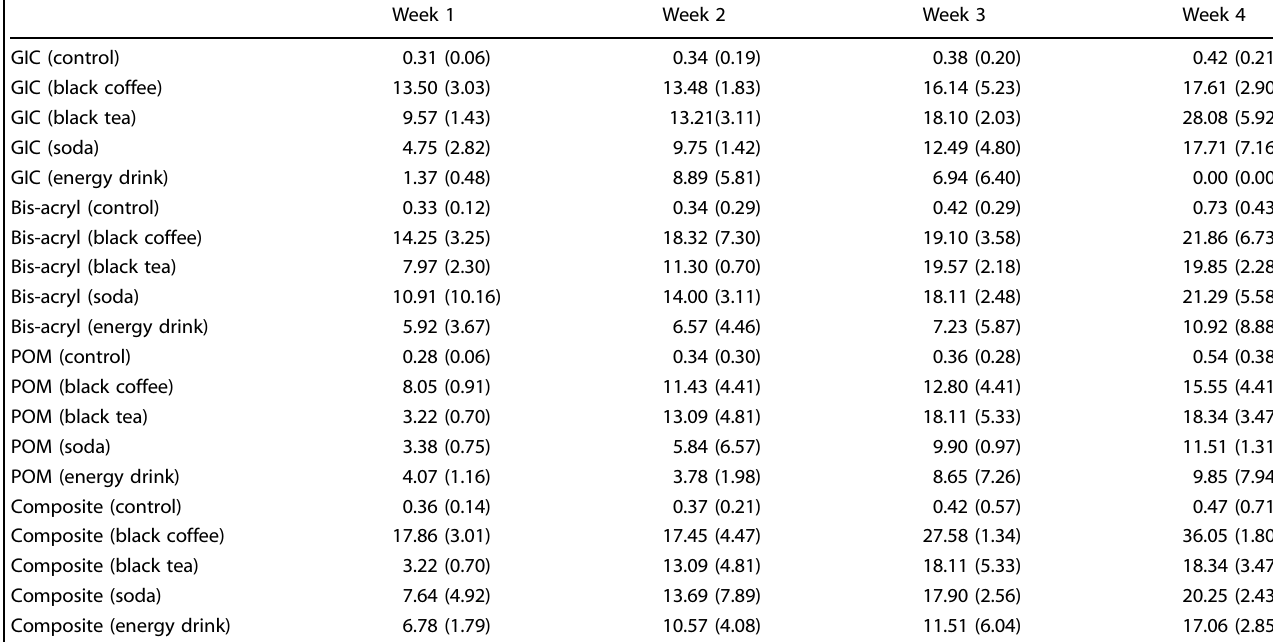
Table 5. Weekly Δ E values.